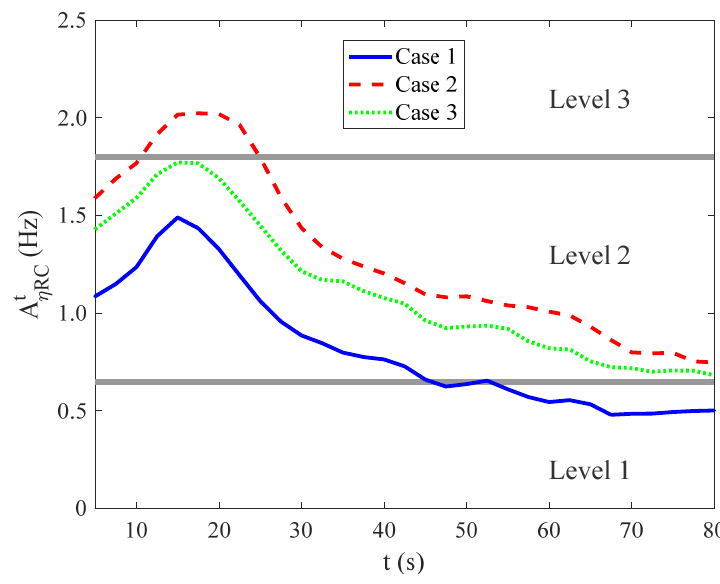
Figure 17. Time-varying combined attack activity rates with SAS off.